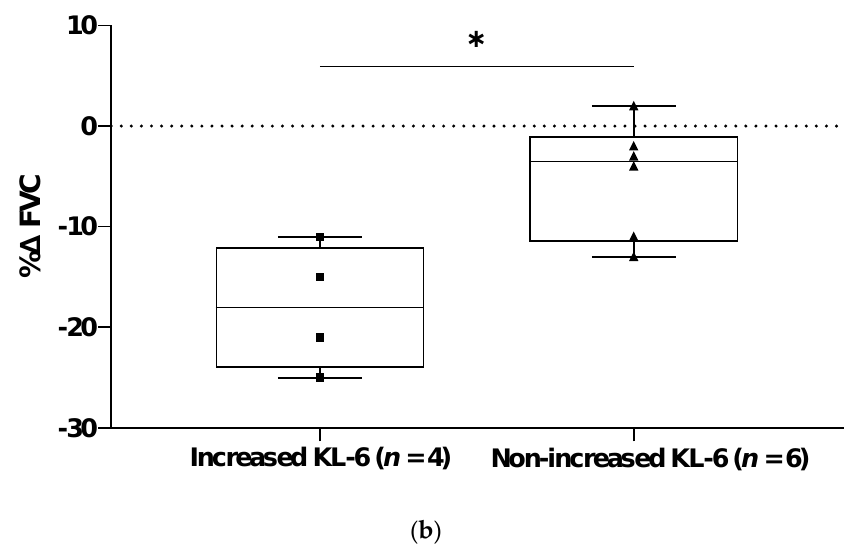
Figure 3. ( a ). After 12 and 24 months of Nintedanib treatment, serial concentrations identified 4/10 patients (40%) who showed a progressive increase in KL-6 levels during follow-up, and the other 6/10 (60%) who showed decreasing KL-6 concentrations. ( b ) Patients in the increased KL-6 group showed a significantly greater decline in %ΔFVC compared to those in the non-increased KL-6 group over the clinical course. * p < 0.05; ** p < 0.01. Abbreviations: IPF, idiopathic pulmonary fibrosis; KL-6, Krebs von den Lungen-6; FVC, forced vital capacity.